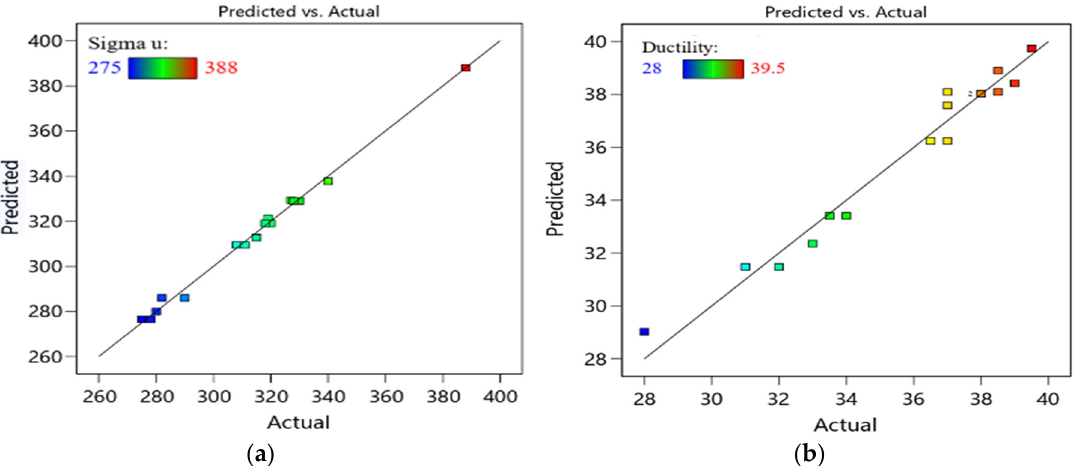
Figure 9. Predicted and actual value of ECAP responses σ u ( a ) and D ( b ).